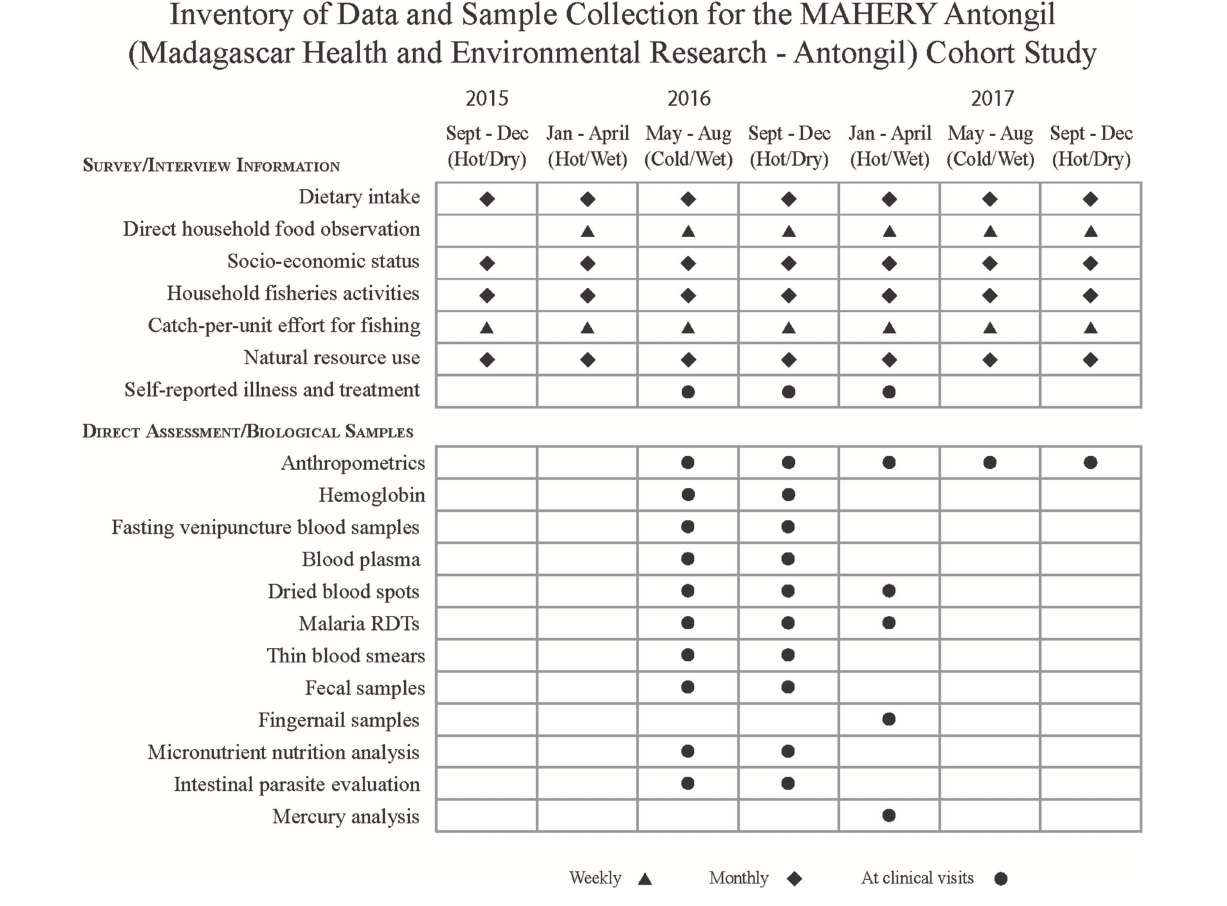
FIGURE 2 | Data and samples collected during the MAHERY-Antongil cohort